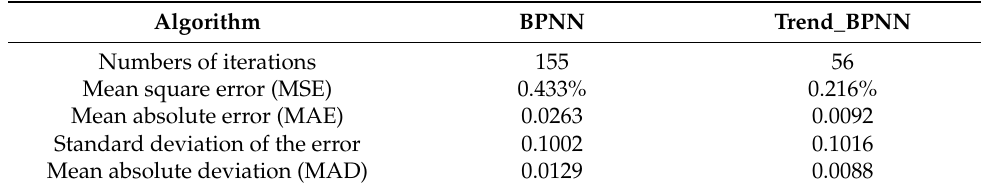
Table 3. Performance comparison before and after adding the trend factor.